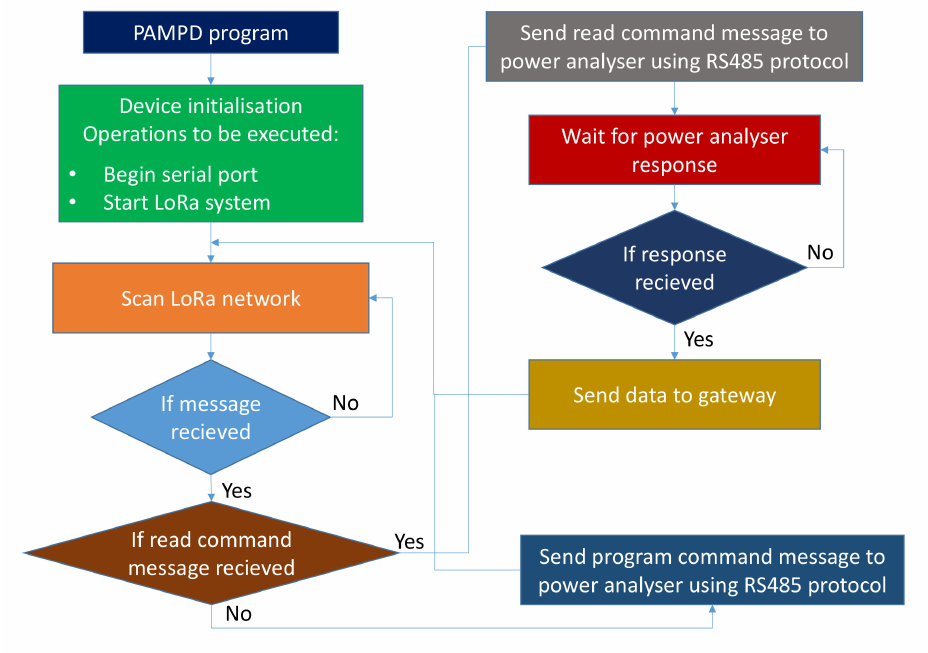
Figure 6. Flowchart for the